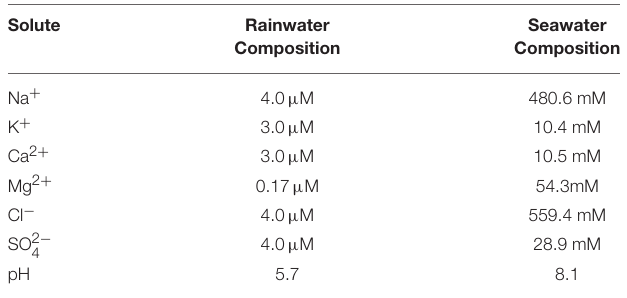
TABLE 4 | Initial water compositions for freeze models (from Berner and Berner,